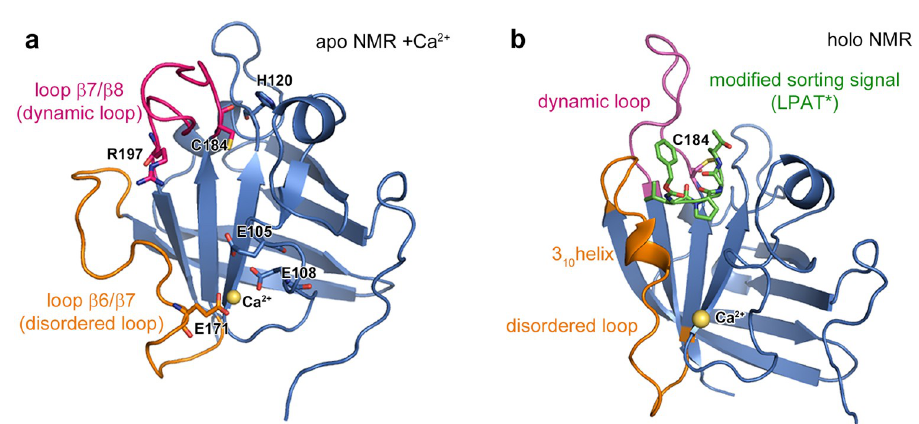
Fig 1. NMR-based structures of apo- and holo-SrtA. a) The structure of apo-SrtA (PDB: 1IJA [36]) is shown in cartoon representation. A Ca 2+ ion is artificially added to the figure to show the initial structure used for the StrA-Ca simulations. The catalytically crucial amino acids and Ca 2+ binding residues are shown in stick representation. Dynamic and disordered loops are colored in magenta and orange, respectively. b) Holo-structure of SrtA with bound Ca 2+ and a covalently attached modified sorting signal (PDB: 2KID [33] LPAT � , green stick representation).